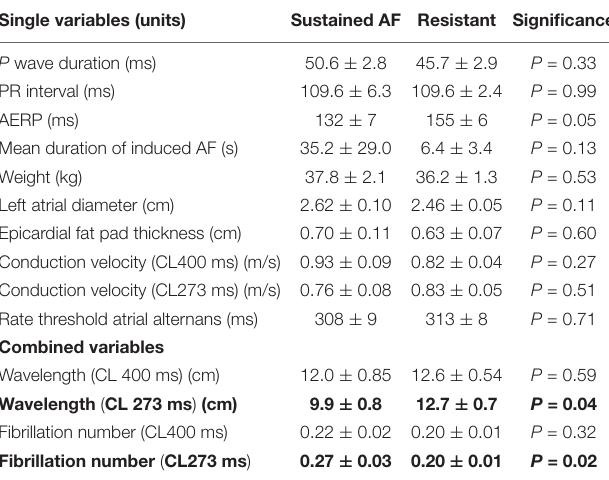
TABLE 1 | Differences in baseline characteristics between the sheep developing sustained atrial fibrillation ( N = 5) and those who were resistant ( N = 13). Single variables (units)